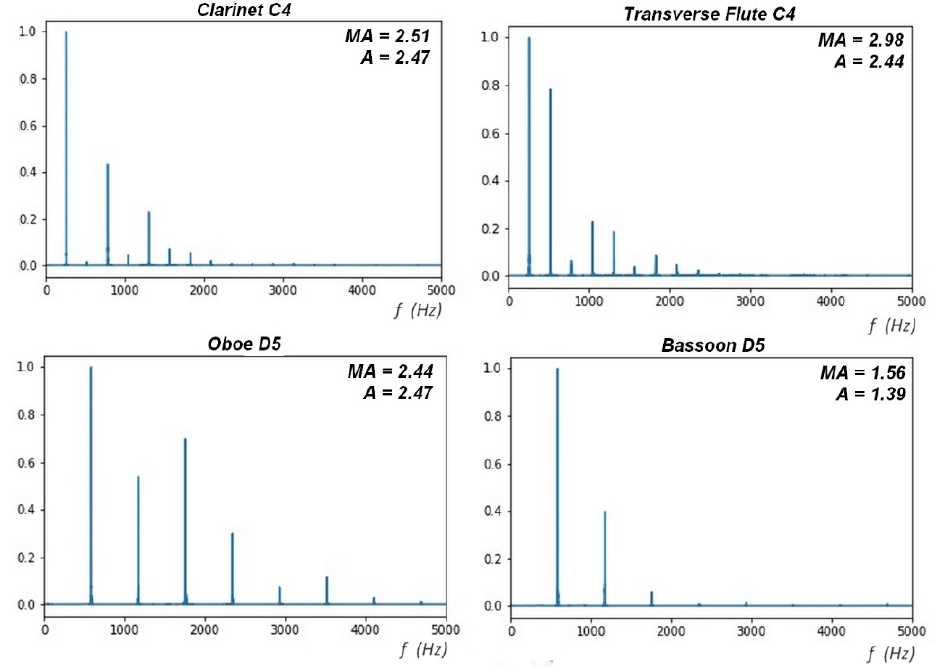
Figure 11. Variation of the mean amplitude of Fourier spectra. Sound C4 top panel: Clarinet ( MA = 2.80) and Transverse Flute ( MA = 1.30). Lower panel sound D5 Oboe ( MA = 2.44) and Bassoon ( MA = 1.56).